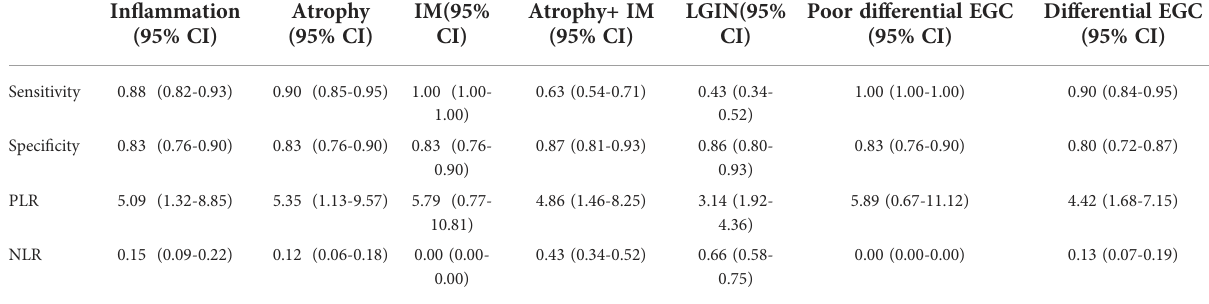
TABLE 3 Detailed results of the model